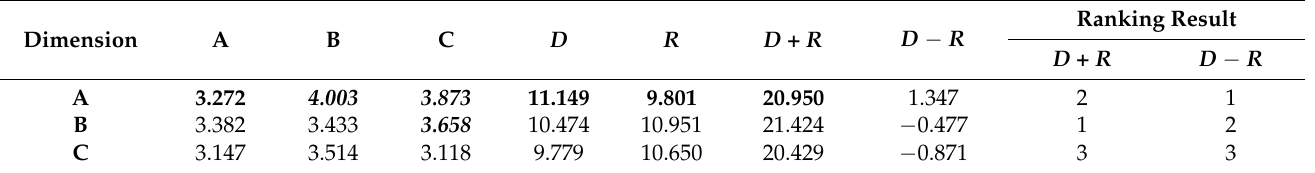
Table 1. The total-related matrix T of dimensions (threshold value ≥